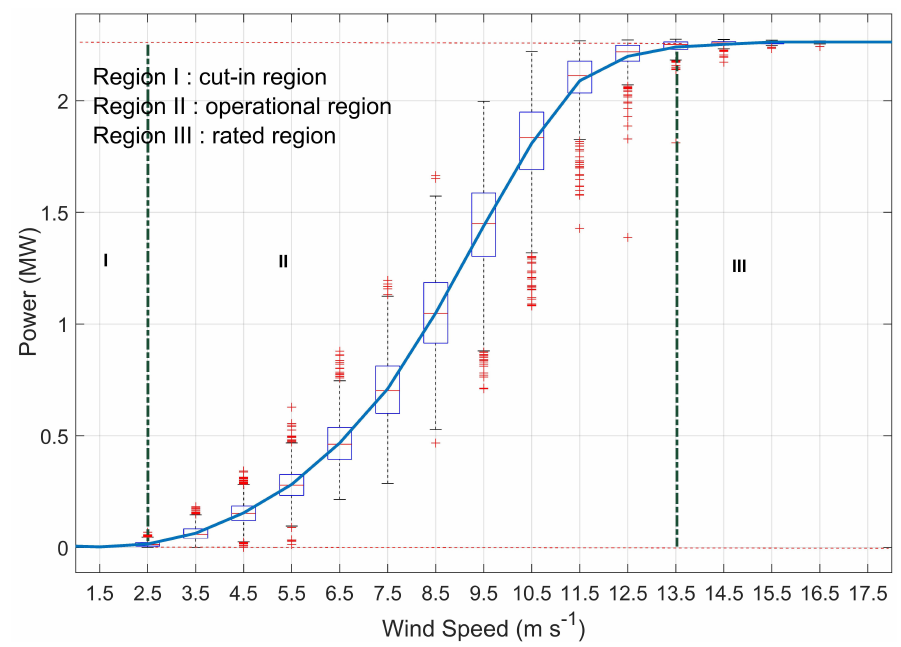
Figure 1. Power curve for the 2.5 MW study turbine, derived using ten-minute data from 20 February to 18 June 2018 and bins of 1 m · s − 1 . Cut-in region, operational region and rated region are